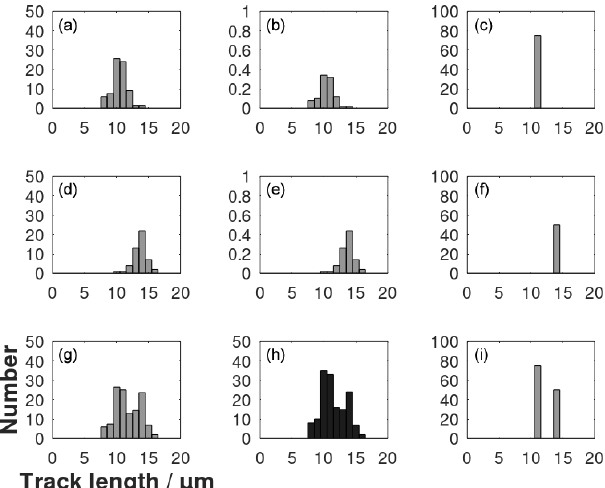
Figure A1. Illustration of deconvolution of a track length his- togram. The dark grey histogram in panel (h) is the observed his- togram. The histogram in panel (i) is an initial guess of a decon- volved histogram with 80 and 50 tracks in each column. The his- tograms in panels (f) and (c) are the two columns of the histogram in panel (h) separated. The histograms in panels (b) and (e) are nor- malizations of histograms observed after track annealing in the lab- oratory. They are named filters. The histogram in panel (a) is the histogram in panel (b) multiplied by the number of tracks in the histogram in panel (c) . The histogram in panel (d) is the histogram in panel (e) multiplied by the number of tracks in the histogram in panel (f) . The histogram in panel (g) is the histogram in panel (a) plus the histogram in panel (d) . The histogram in panel (g) is then the result of the convolution of the histogram in panel (i) with the filters in panels (b) and (e) . The synthetic histogram in panel (g) is compared with the observed histogram in panel (h) ; however, the left part is dissimilar. Therefore, the suggested deconvolved his- togram in panel (i) is not